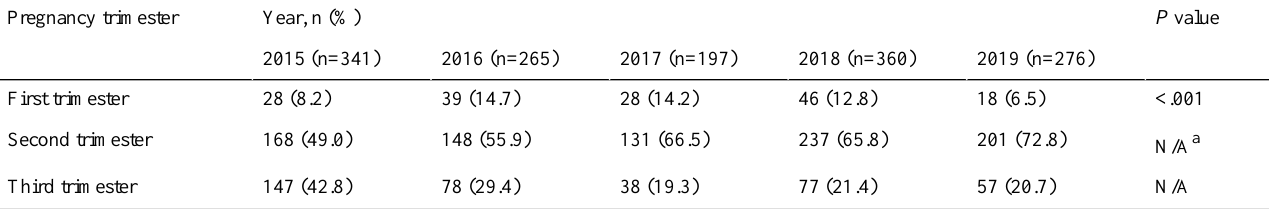
Table 2. Timing of the first antenatal care visit during pregnancy by year among pregnant women in the Ambanja district, Madagascar.